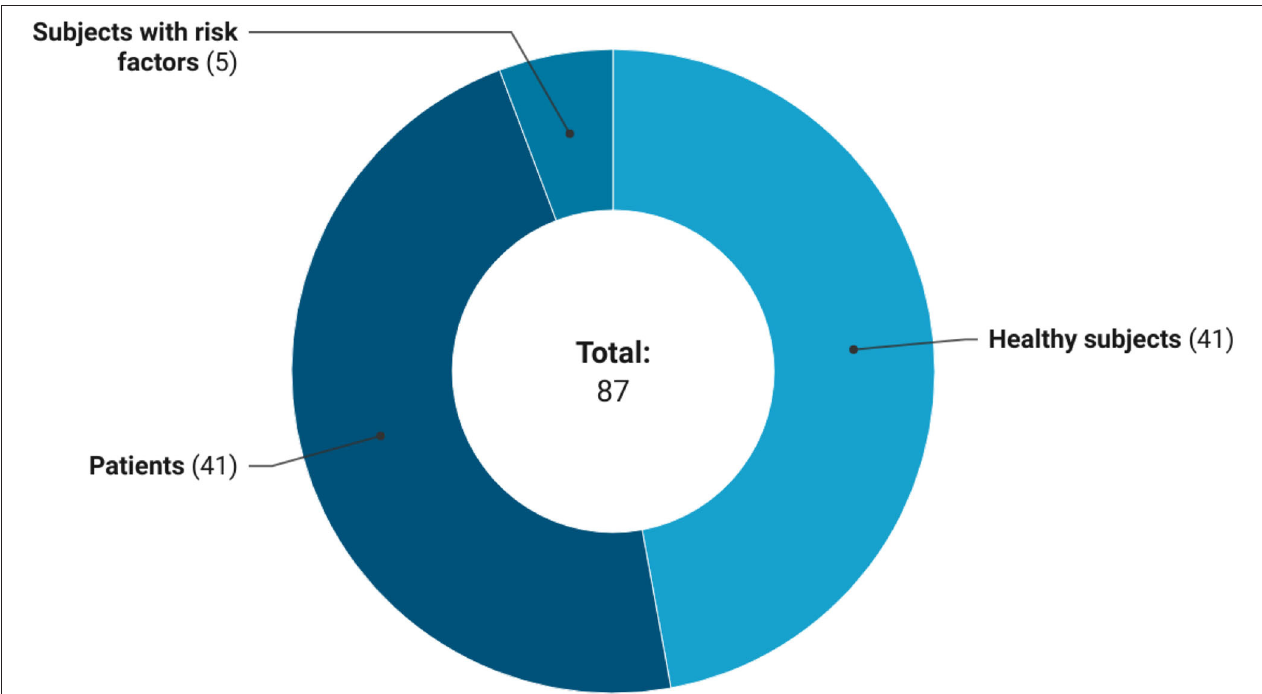
FIGURE 6 | Health status of subjects included in the registered clinical